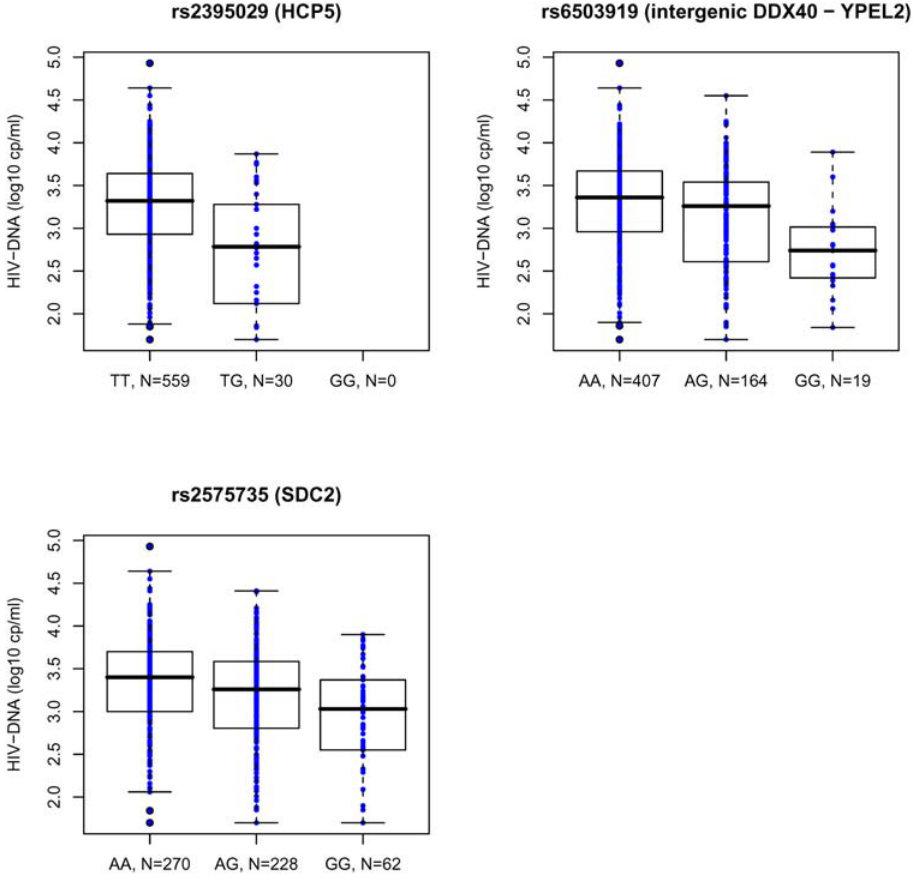
Figure 4. Boxplots for HIV-DNA levels in the PRIMO cohort for the three major SNPs. Cellular HIV-DNA level is highly correlated with the rs2395029 (HCP5), rs6503919 (intergenic DDX40 – YPEL2) and rs2575735 (SDC2) genotypes.